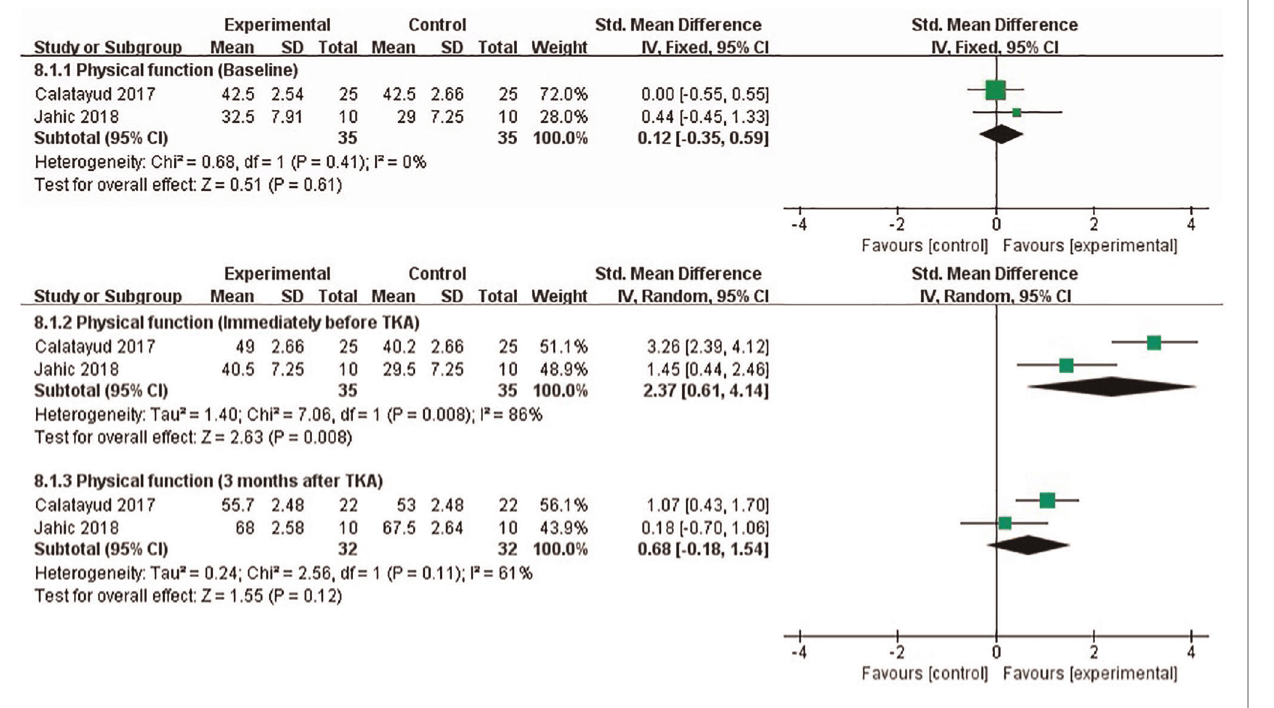
FIGURE 10 | Meta-analysis on Physical